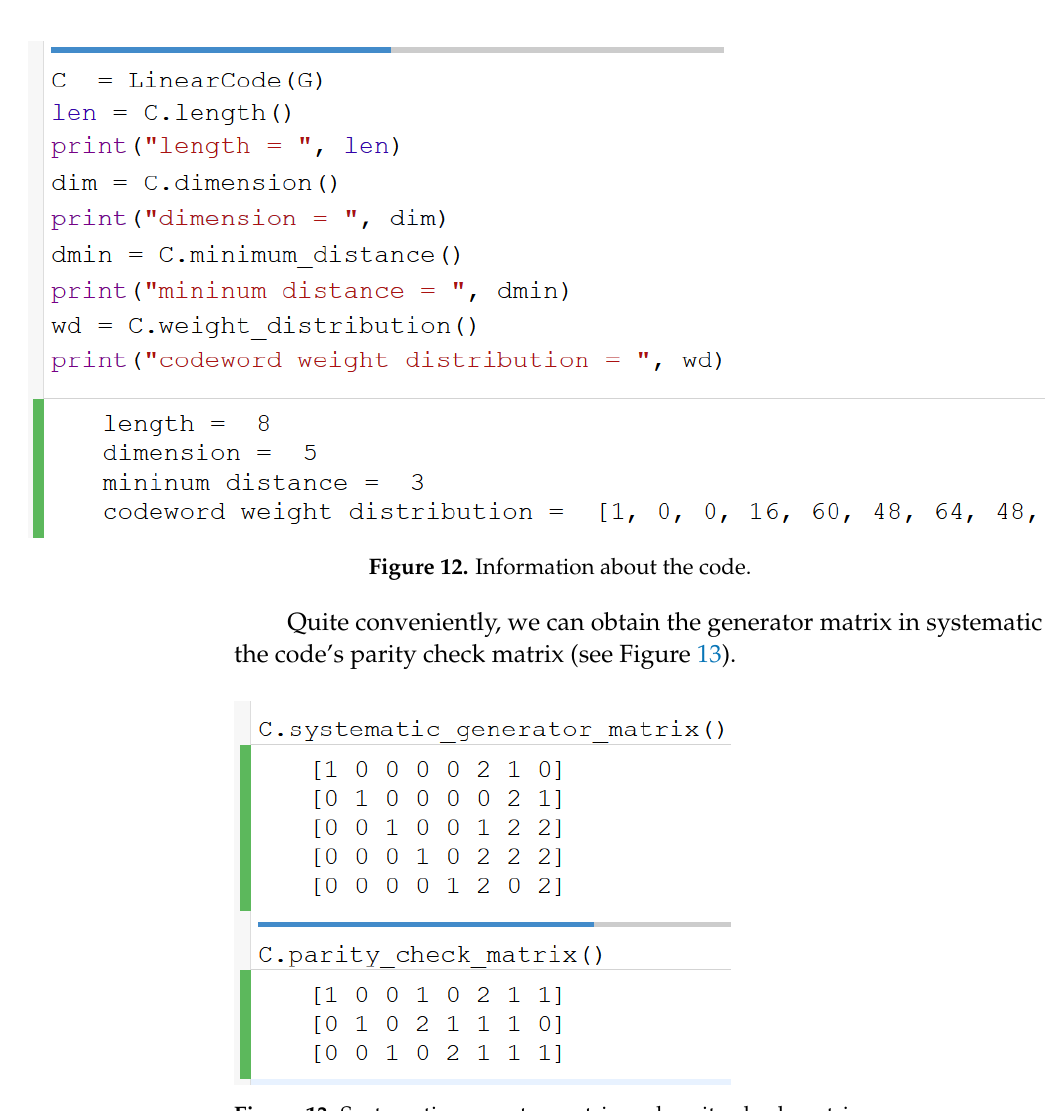
Figure 13. Systematic generator matrix and parity check matrix.